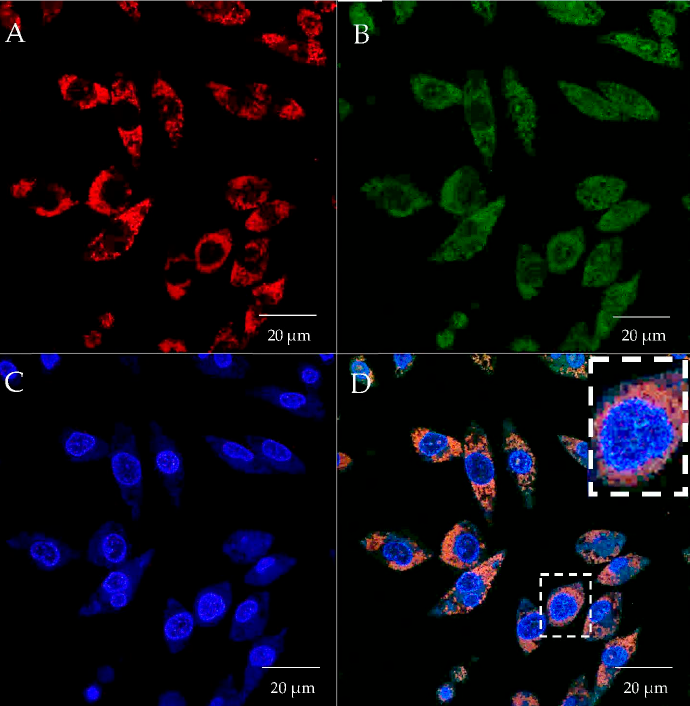
Figure 11. Cellular uptake and intracellular colocalization of PEI–DQA (25 kDa)/TAT/pND1 com- plexes formulated at an N/P ratio of 50:2:1. Mitochondria stained red by MitoTracker ( A ), green labeled pND1 ( B ), nuclei marked blue by DAPI ( C ), and merged image ( D ).